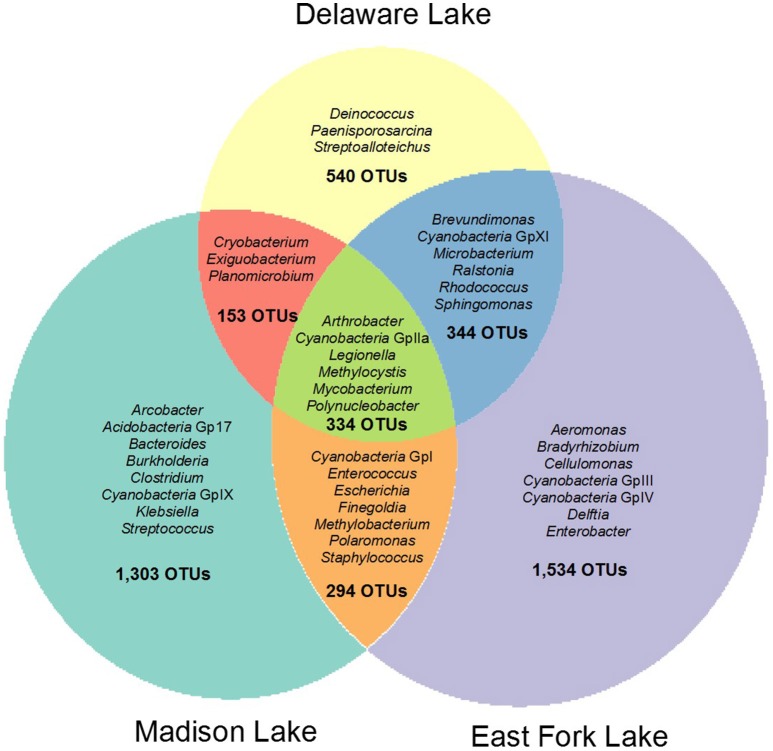
Weighted Venn diagram representing shared and unique bacterial compositions in three recreational freshwaters. The bacterial OTUs at the genus levels were defined with 16S rRNA gene sequences based on a cut-off value of >97% sequence similarity.